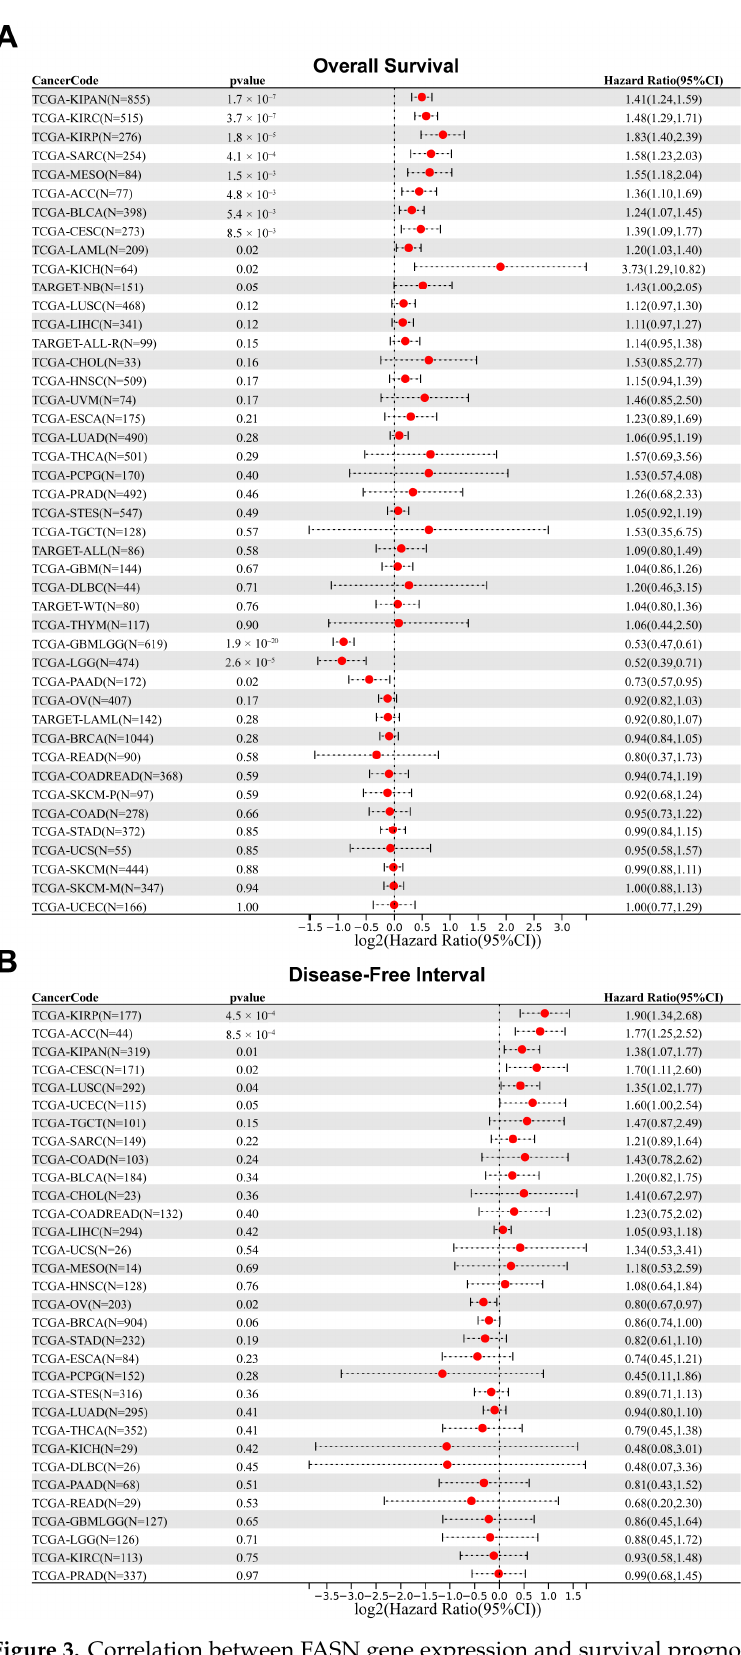
Figure 3. Correlation between FASN gene expression and survival prognosis of cancers in TCGA. We used the Sangerbox3.0 to perform overall survival ( A ) and disease-free interval ( B ) analyses of different tumors in